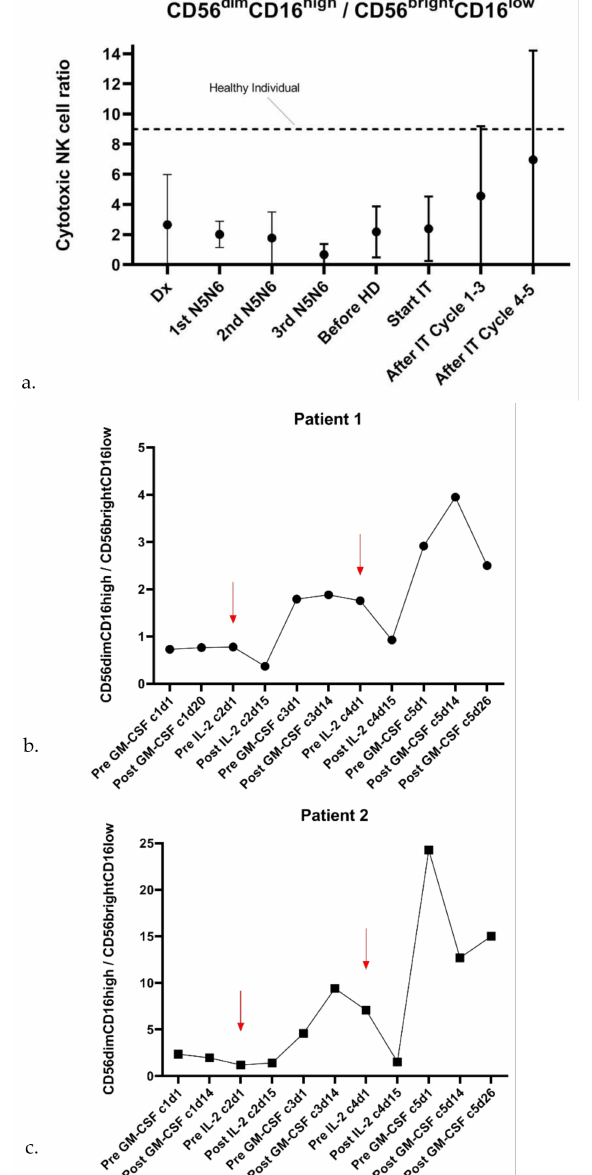
Figure 6. The cytotoxic CD56 dim CD16 + /CD56 bright CD16 − NK-cell ratio during HR-NBL therapy. ( a ) The ratio of absolute CD56dimCD16+ and CD56brightCD16- Trucount cell numbers is highly variable between patients and is decreased at diagnosis and during therapy of HR-NBL patients. Dx: n = 7, 1st N5/N6: n = 11, 2nd N5/N6: n = 10; 3rd N5/N6: n = 11, before HD: n = 7, start IT: n = 7, After IT Cycle 1–3: n = 10, After IT cycle 4–5: n = 8. The dotted line reflects the reference